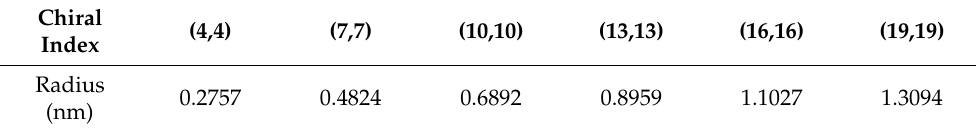
Figure 1. Geometric schematic of the simulation model. Based on the Cartesian coordinates, the crystallographic orientations of the Cu substrate are aligned along the [100], [010], and [001] directions, respectively. The (001)/[010] (plane/front) half crack is located at the Cu substrate, and the CNT was located at the opposite side of the specimen. Table 2. Radius of the CNT corresponding to the chiral vector of the CNT utilized in this study.